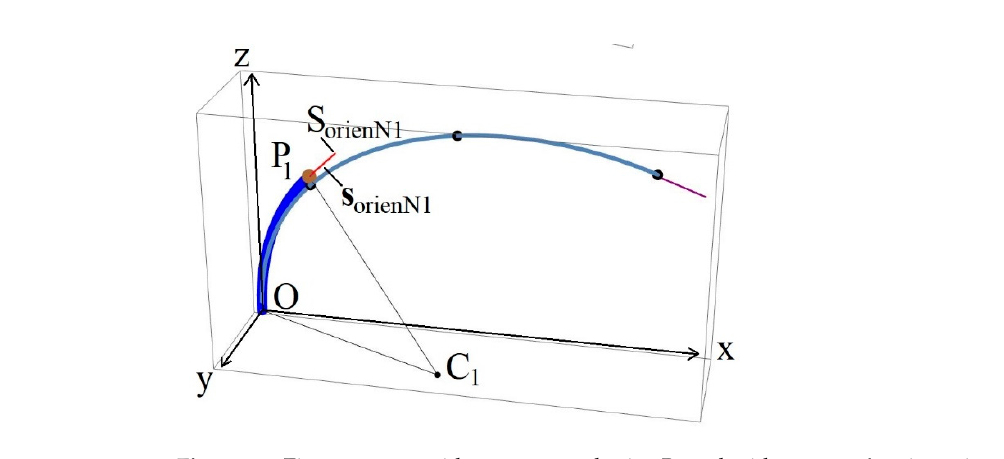
Figure 10. First segment with segment endpoint (cid:1842) (cid:2869) and with segment’s orientation vector